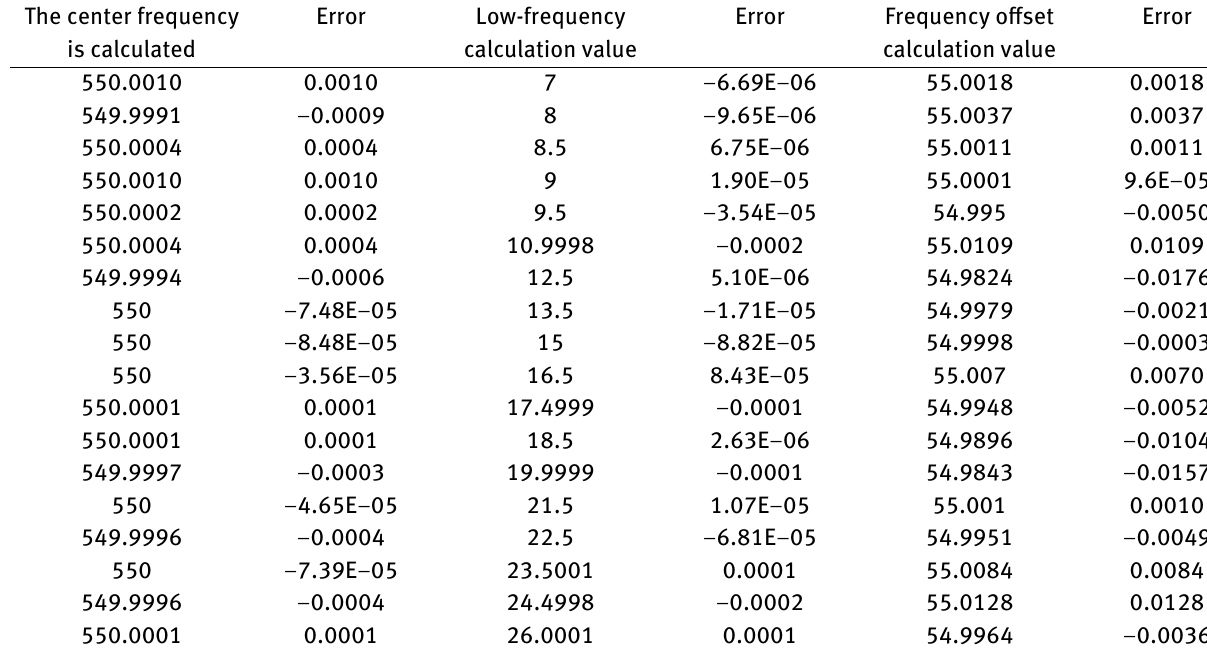
Table 1: Simulation results of FFT spectrum correction algorithm when the center frequency is 550 Hz The center